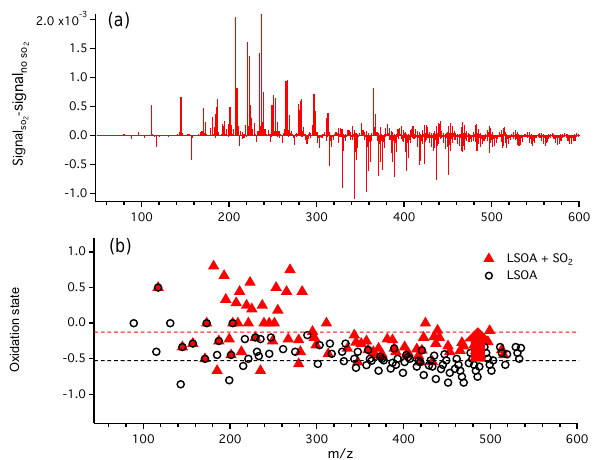
Figure 7. Growth of particle volume concentration as a function of reacted α -pinene under dry conditions. No significant change in ( m/z 96.96) 4 SOA formation was